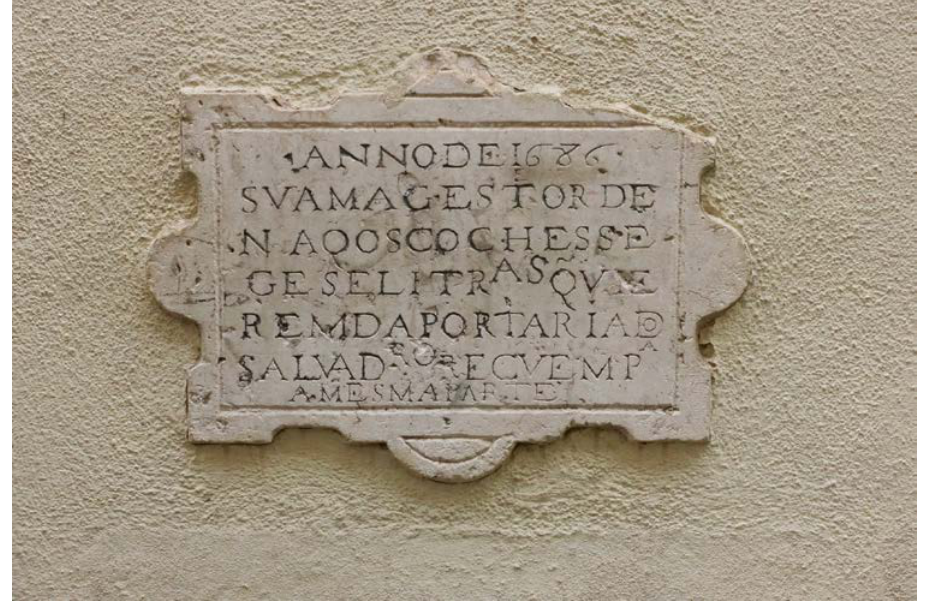
Figure 6 – Epigraph on the regulation of carriage traffic in Lisbon, 1686 , Photo by Ivan Batinic / Alamy Foto de stock. By permission of the Universidad de Alcalá, Facultad de Filosofía y Letras Alcalá de Henares,